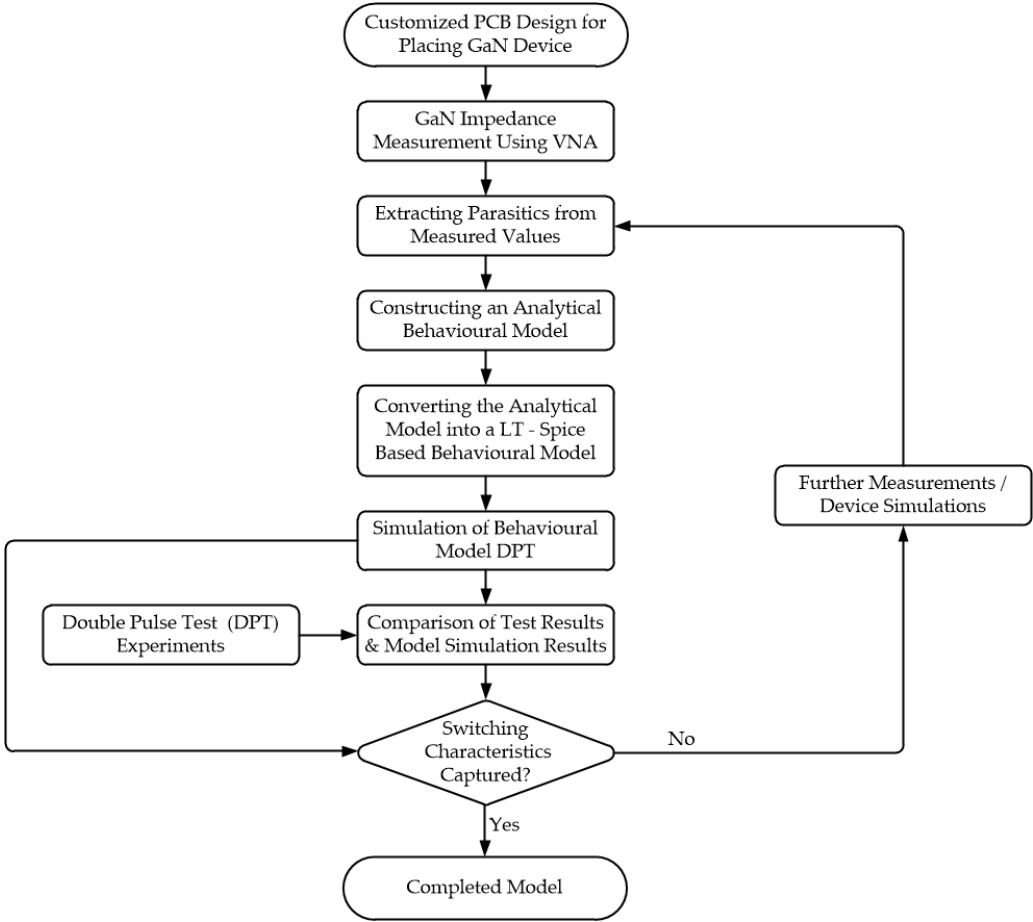
Figure 2. Flow diagram of the GaN device modelling design using VNA measurement and DPT results.